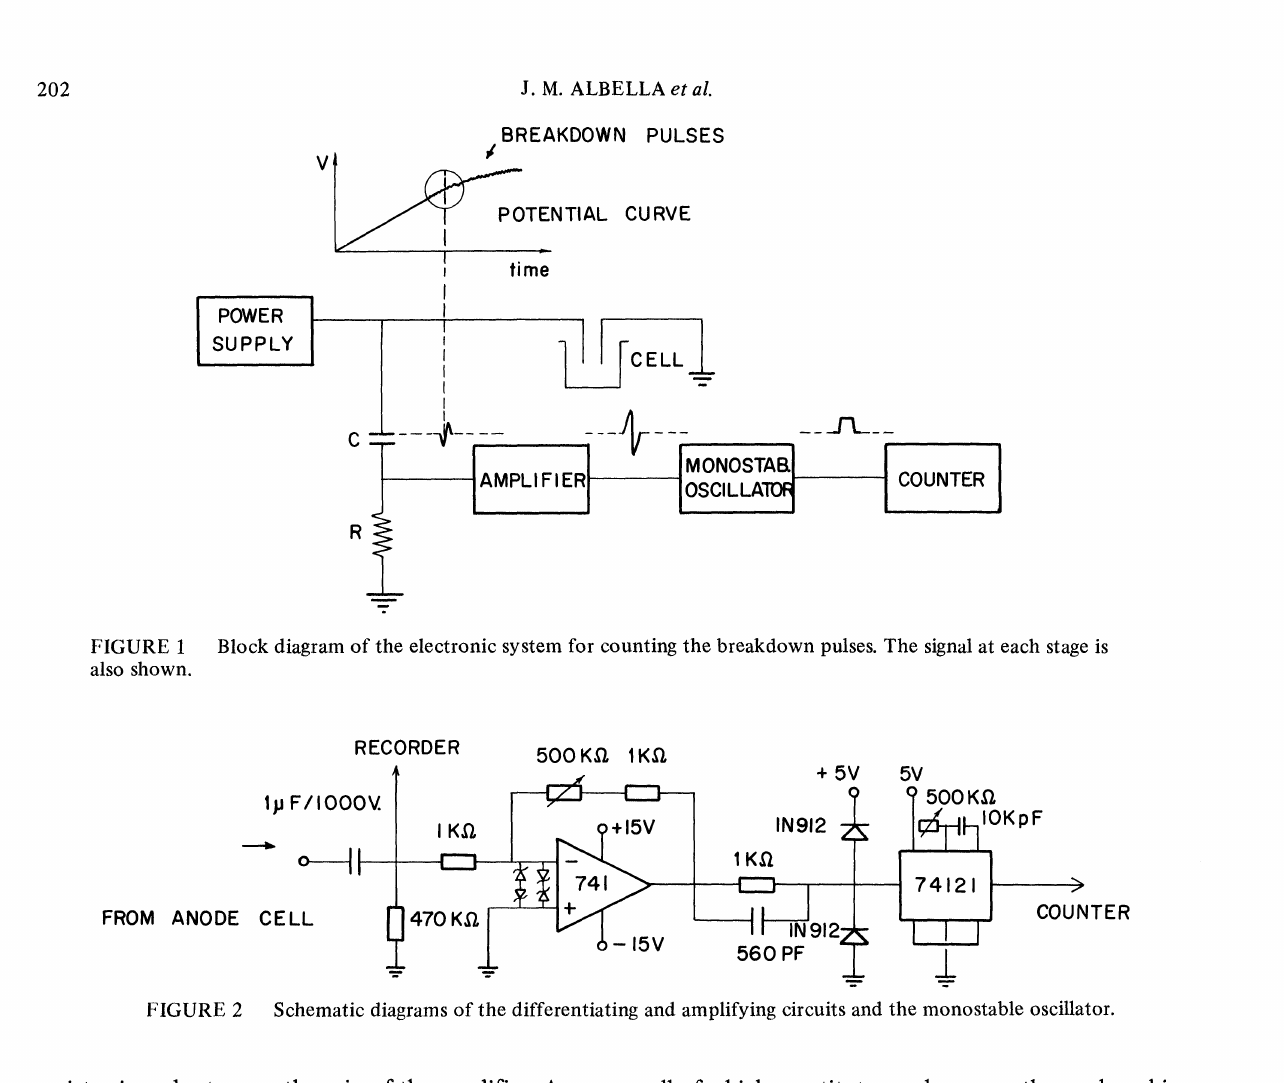
FIGURE 2 Schematic diagrams of the differentiating and amplifying circuits and the monostable